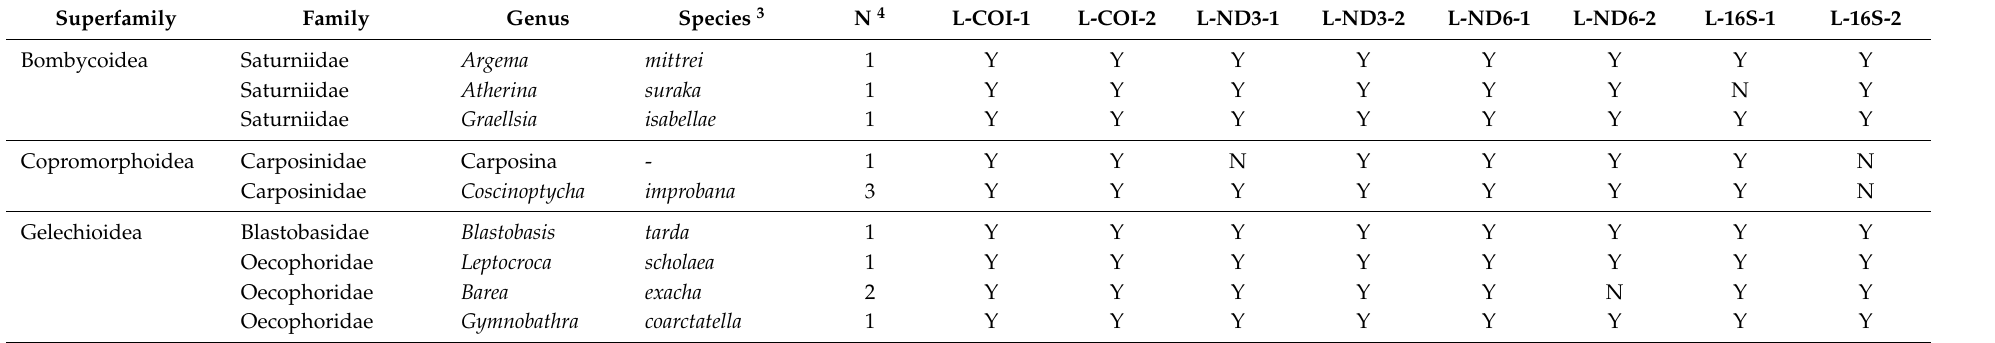
morphology or DNA barcoding [51]; 4 Number of specimens tested; 5 Contain pests or parasitoids of animals, not plant Table 5. Summary of PCR success 1 with universal primers 2 for individual specimens of